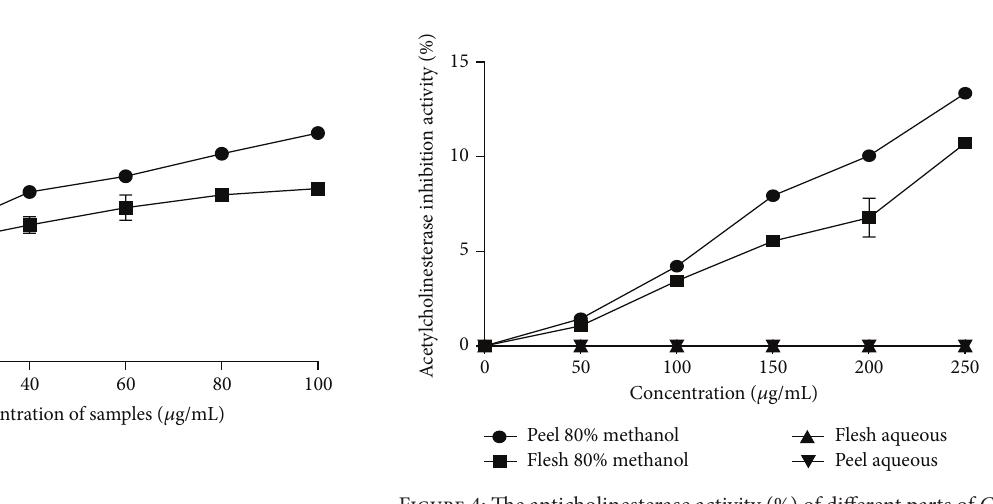
Figure 3: The scavenging activity of aqueous extract of different parts of C. betacea assayed by DPPH free radical scavenging method ( 𝑛 = 3 ).